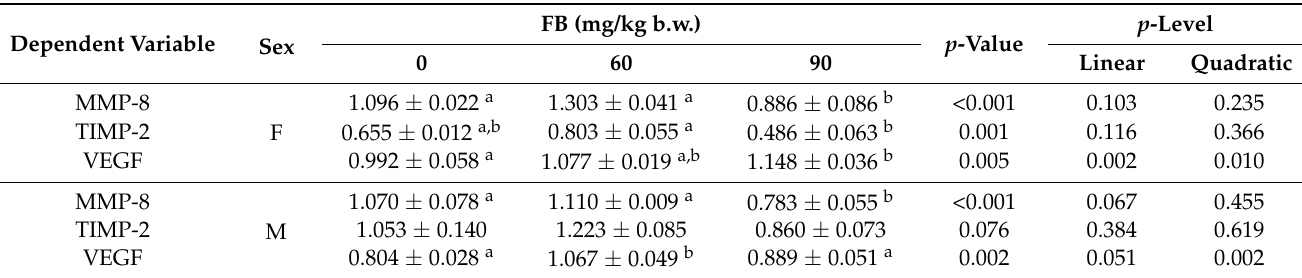
Table 4. Western blot protein expression. The relative abundance of MMP-8, TIMP-2 and VEGF was evaluated densito- metrically and expressed as the ratio relative to β -actin used as a loading control across all replicates as described in the Materials and Methods section.